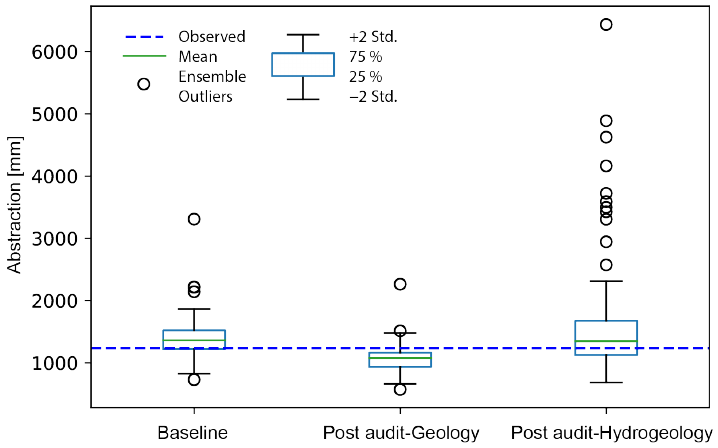
Figure 6. Simulated abstracted groundwater for the three models. The box plot shows the mean, quantiles, and two standard deviations, while the dots indicate the Monte Carlo ensemble members outside two standard deviations. The blue and dotted line shows the observed abstraction.